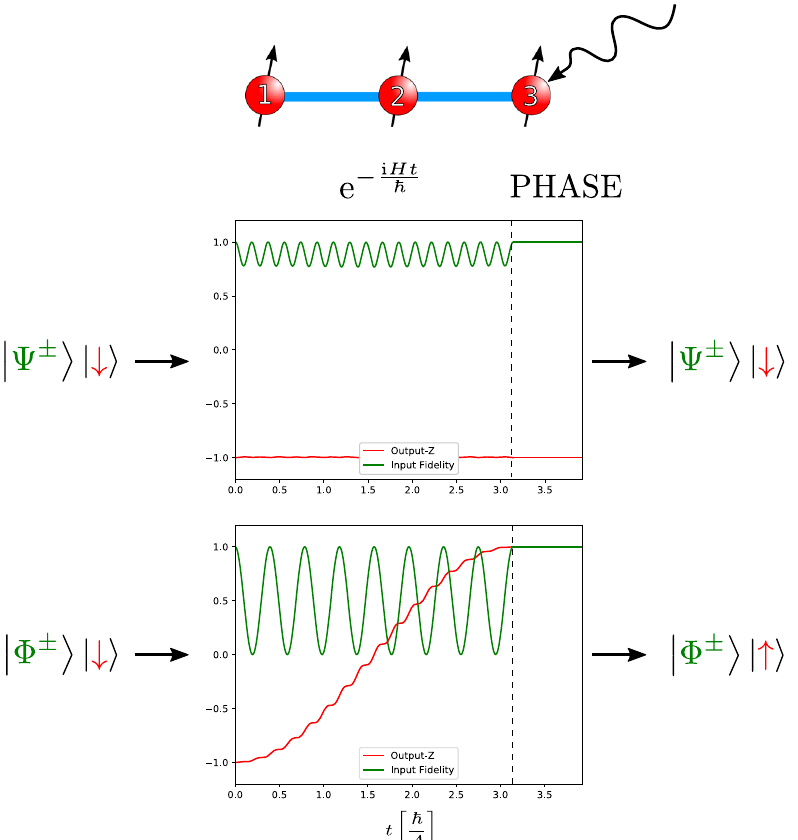
Fig. 1 Dynamics of Neuron 1. Schematic depiction of the excitation-number detecting neuron (top) and plots of the time-evolution of the output-qubit state (red) and the overlap between the state of the input qubits and their initial state (green) for the four Bell states during the operation of the neuron. As illustrated in these plots, the state of the output is either fl ipped or not depending on whether the input contains an odd (middle) or even (bottom) number of excitations. In contrast, the input qubits return to their initial states in all four cases. Parameters used are l = 17, k = 8, which yields an average operational fi delity of 99.98% in the absence of